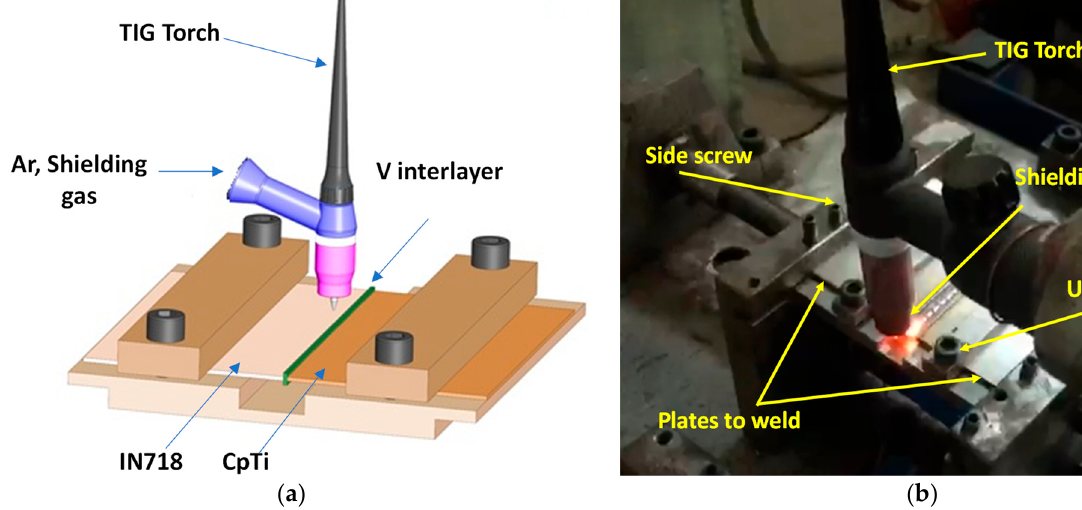
Figure 1. ( a ) Schematic diagram. ( b ) Experimental set-up of TIG welding process.